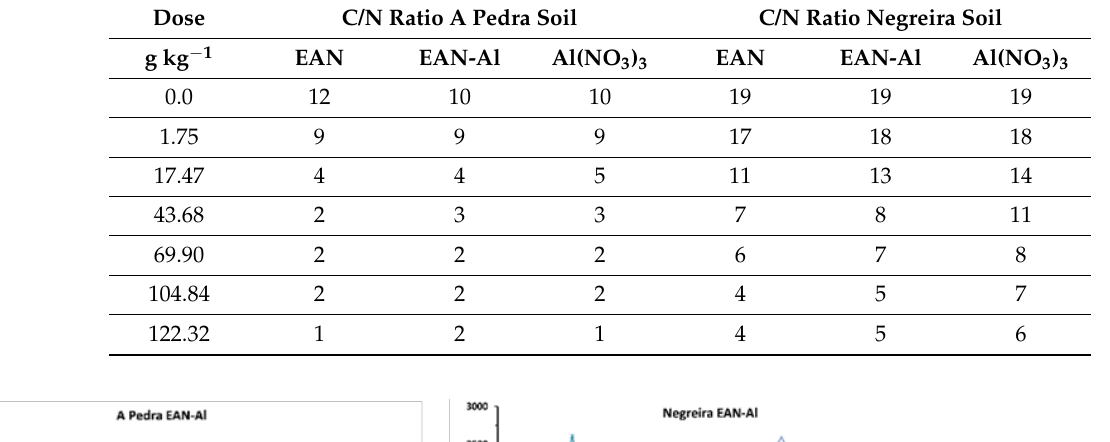
Table 4. C/N ratios in A Pedra and Negreira soils spiked with different doses of ethylammonium nitrate (EAN), ethylammonium nitrate plus aluminium salt (EAN-Al), or aluminium nitrate as already indicated, higher than in the A Pedra soil, varying between 595 and 708 mg (Al(NO 3 ) 3 ) .